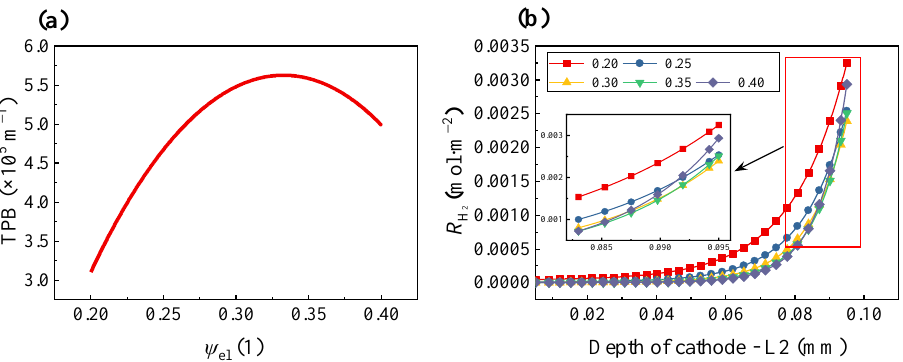
Figure 6. The effect of volume fraction of electrode phase on: ( a ) size of volumetric percolation TPB area; ( b ) hydrogen generation rate at L2.